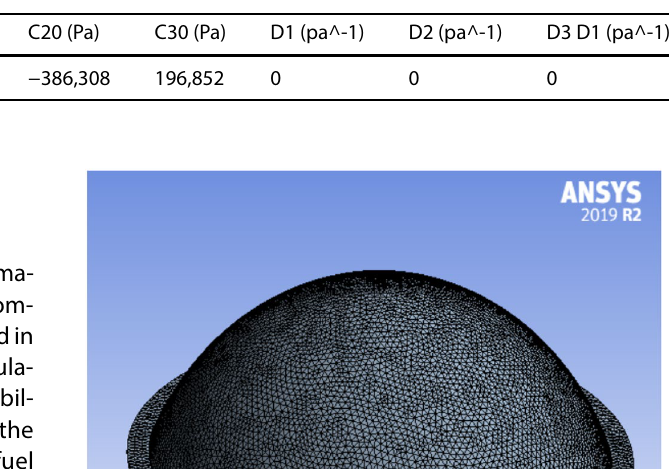
Table 2 Mechanical properties of hyper-elastic diaphragm